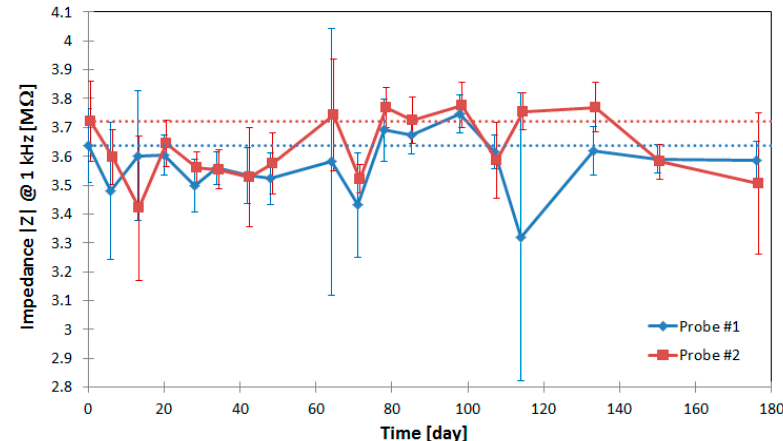
Figure 10. In vitro impedance long-term measurement results between adjacent conductive paths on the flexible cable and the probe shaft for two floating neural probes show an impedance reduction of 1.4% for probe 1 and 5.8% for probe 2 after almost six months.